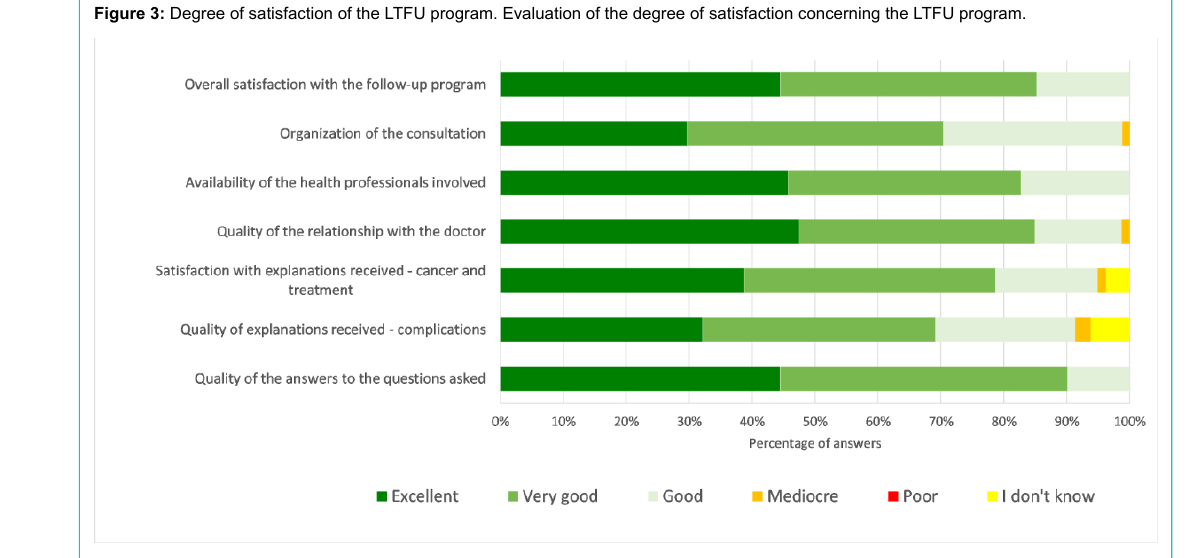
Figure 3: Degree of satisfaction of the LTFU program. Evaluation of the degree of satisfaction concerning the LTFU